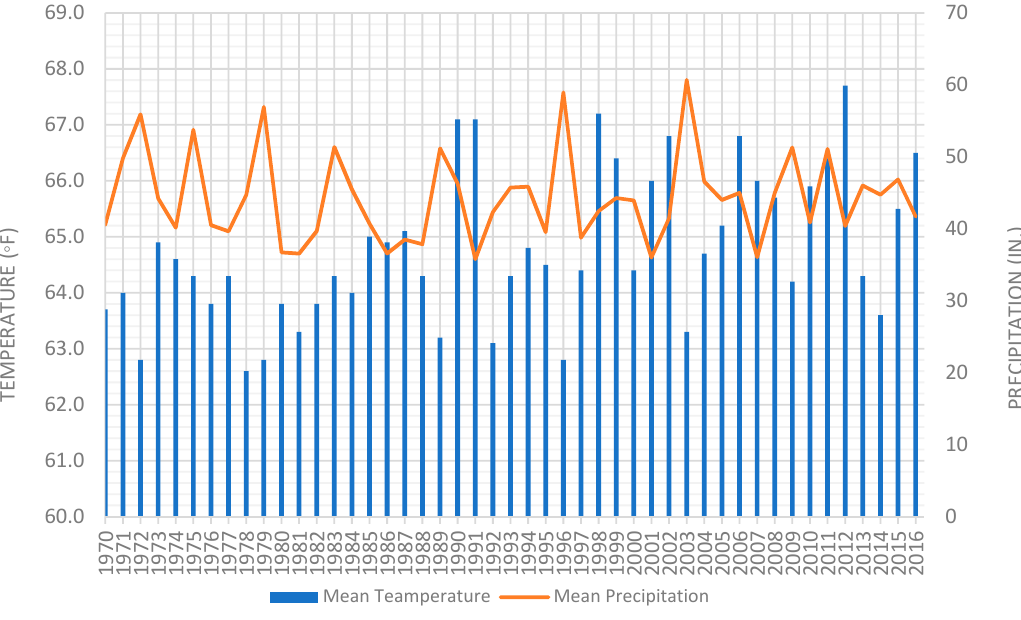
Figure 9. Dynamics of temperature and precipitation change over 45 years.